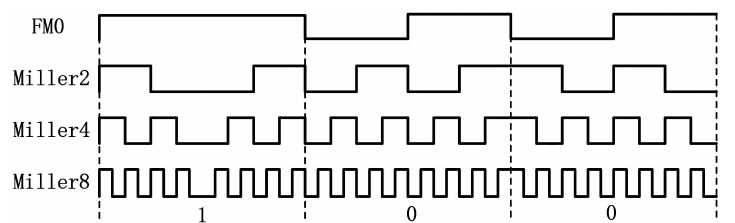
Figure 6. Different encoding methods at the same data rate.